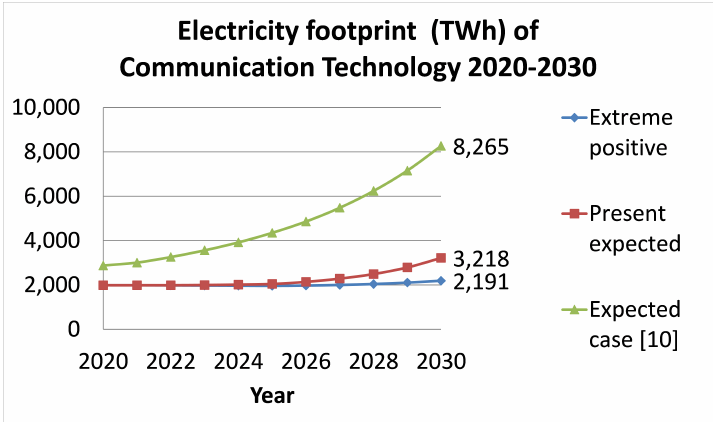
Figure 7. Trends for ICT electric power use 2020 to